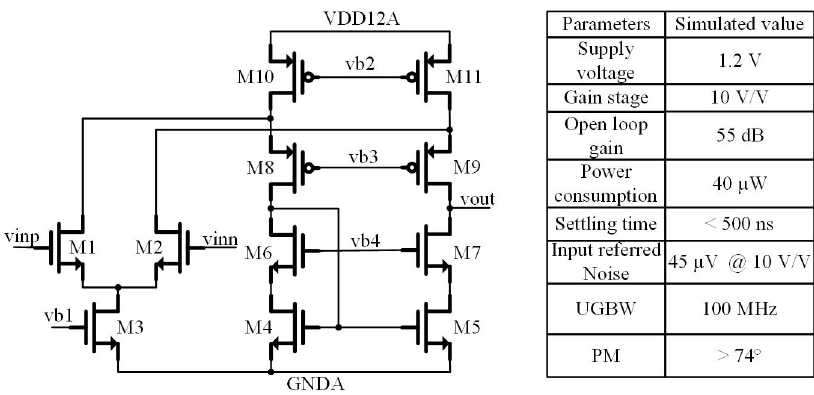
Figure 4. Schematic of the amplifier used in the CTIA.